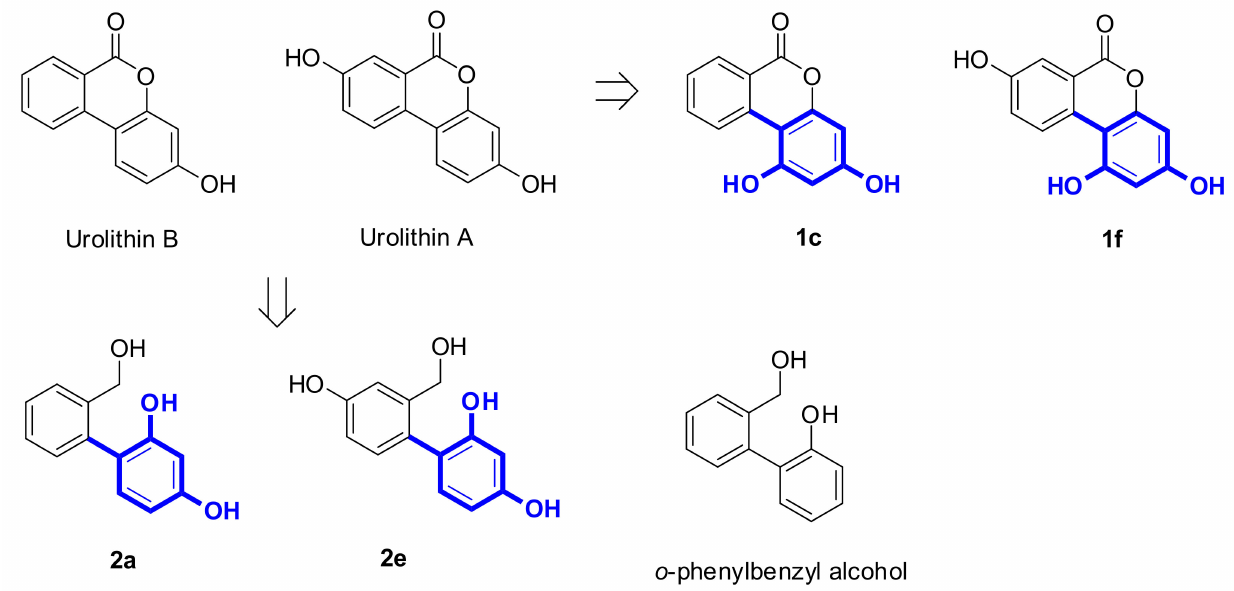
Figure 2. Conversion of urolithin A and urolithin B into urolithin derivatives 1c and 1f possessing a 4-substituted resorcinol moiety and o -phenylbenzyl alcohol derivatives 2a and 2e with a 4-substituted resorcinol moiety. The blue colored part indicates a 4-substituted resorcinol